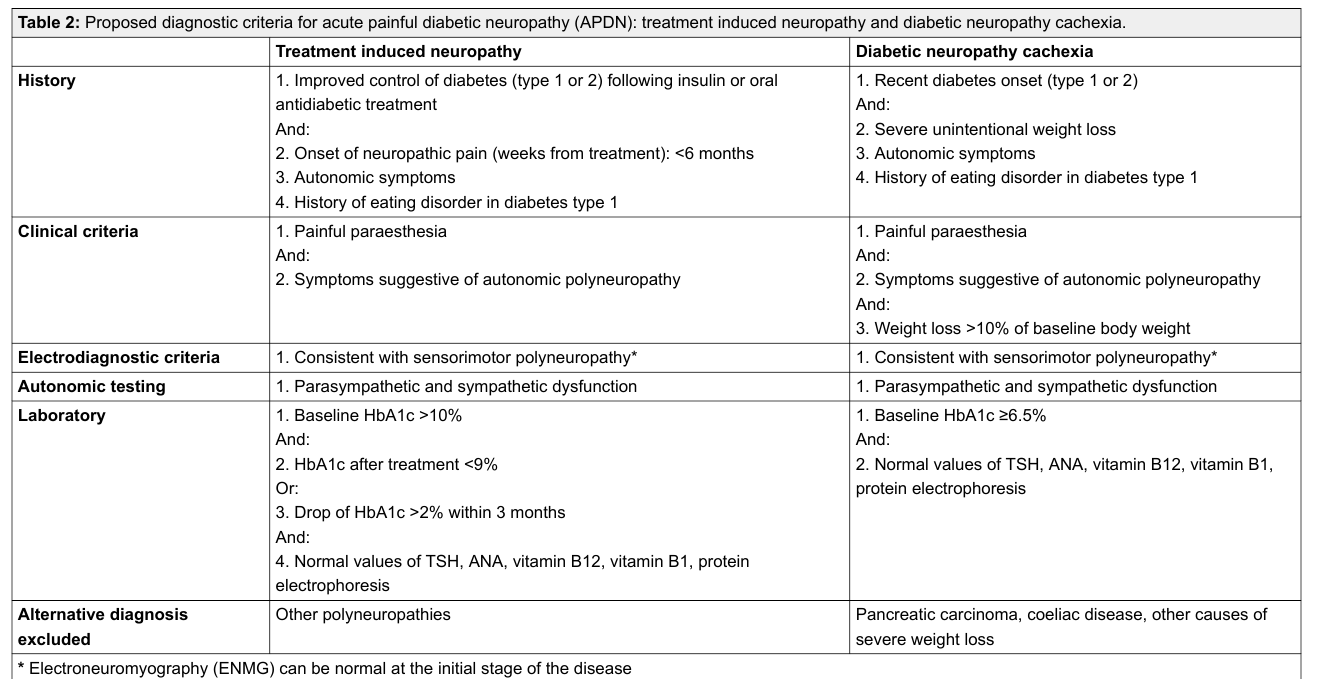
Table 2: Proposed diagnostic criteria for acute painful diabetic neuropathy (APDN): treatment induced neuropathy and diabetic neuropathy